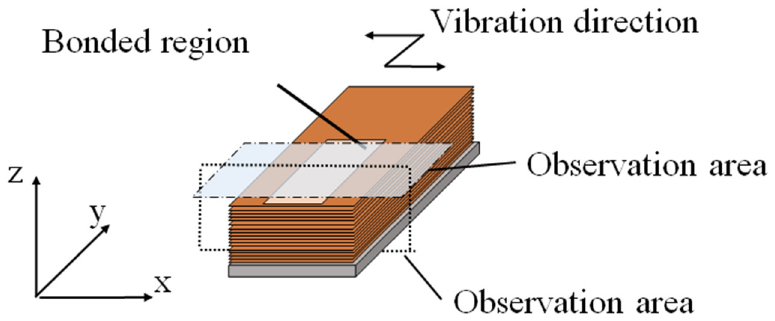
Figure 3. Cross-sectional observation area.